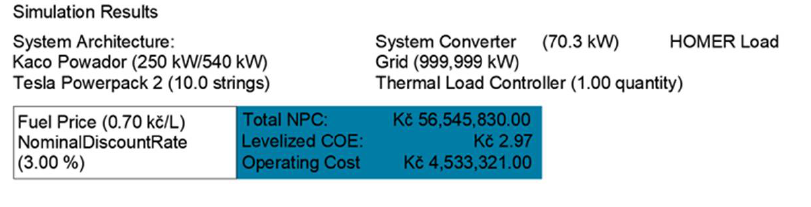
Table 22. Energy bought and sold during the year, difference and price in each month.